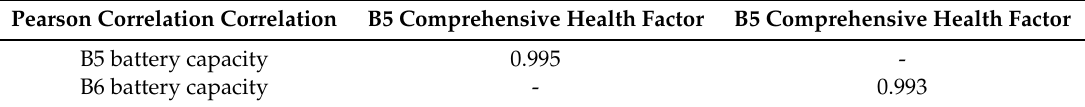
Figure 4. Temperature curve. Table 1. Pearson correlation coefficients for the capacity and comprehensive health